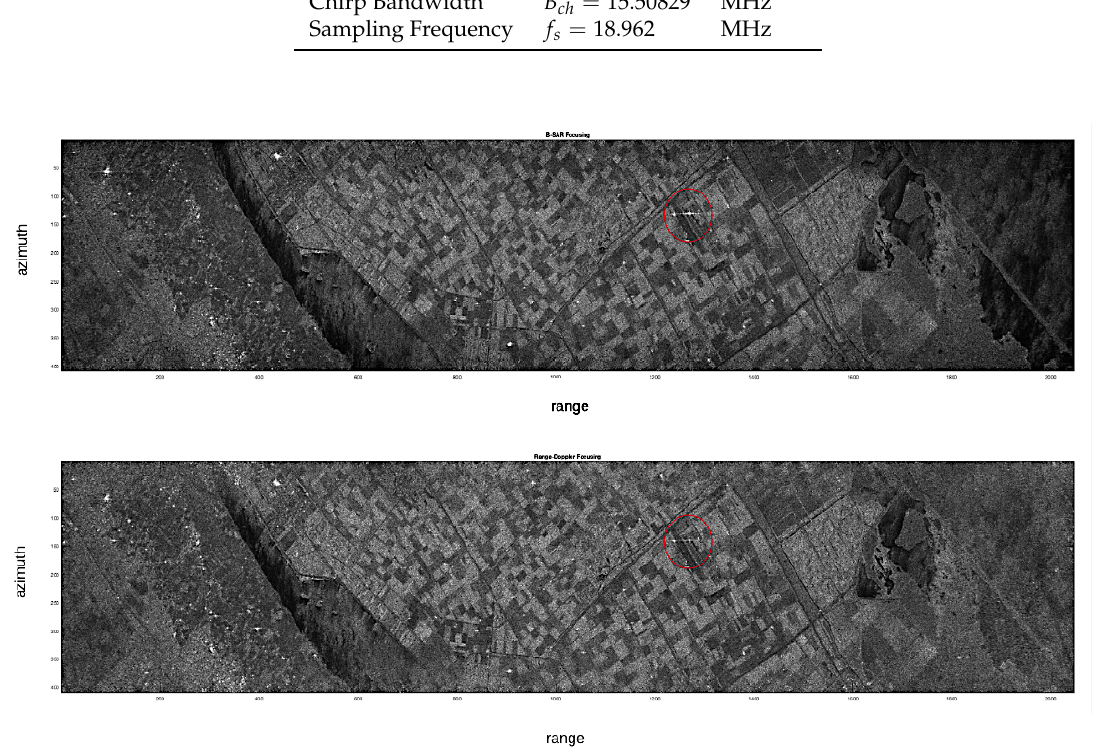
Figure 8. Sample of focused image with the proposed algorithm (upper) compared with the standard focusing obtained via Range Doppler algorithm (lower). ERS 1—Matera. The red circle indicates the point